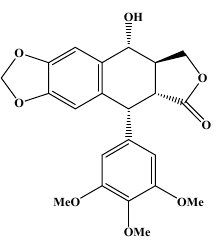
Figure 1. Chemical structure of podophyllotoxin (POD).